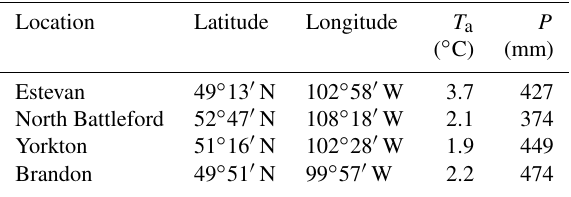
Table 2. Location and climate characteristics (1981–2010 climate normal) of the four selected climate stations located in and near the Pothole Till class. T a is mean annual temperature and P denotes mean annual